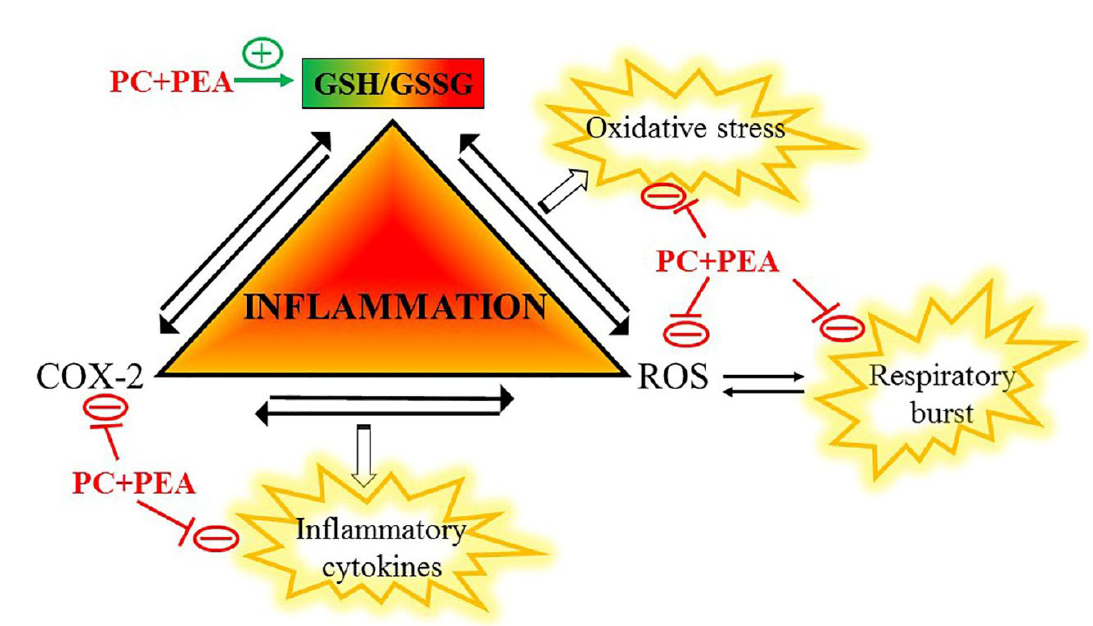
Figure 6. A working model of the molecular mechanisms underlying the antioxidant and anti-inflammatory effects of PC and PEA.